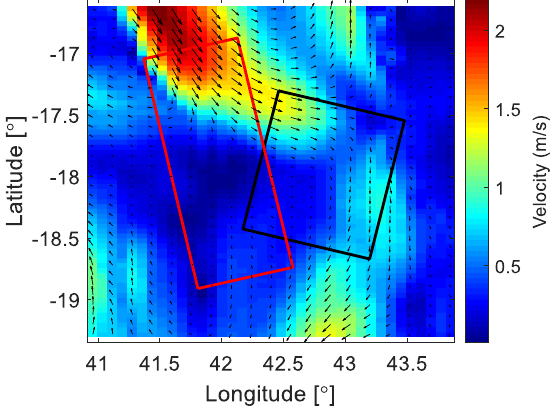
Figure 8. Simulation results of two-dimensional current field.